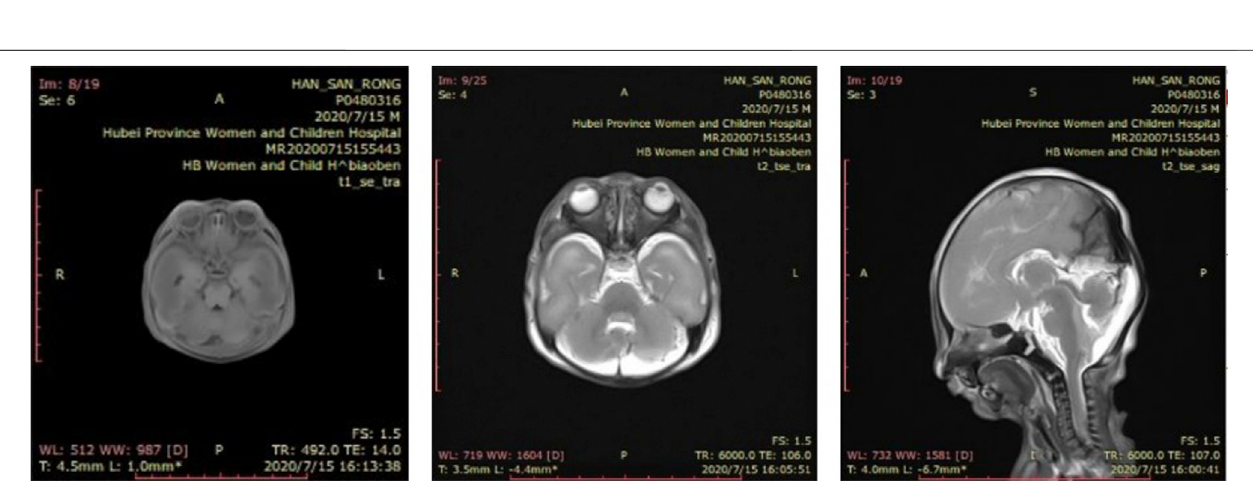
FIGURE 4 | Brain imaging. Cranial MRI showed small lower jaw, displacement of the tough toward the back of the oral cavity and cleft palate and lissencephaly. There was no gyri/sulci clearly seen for both cerebral and cerebellum cortex. (A) T1-weighted coronal image (B) T2-weighted coronal image (C) T2-weighted sagittal